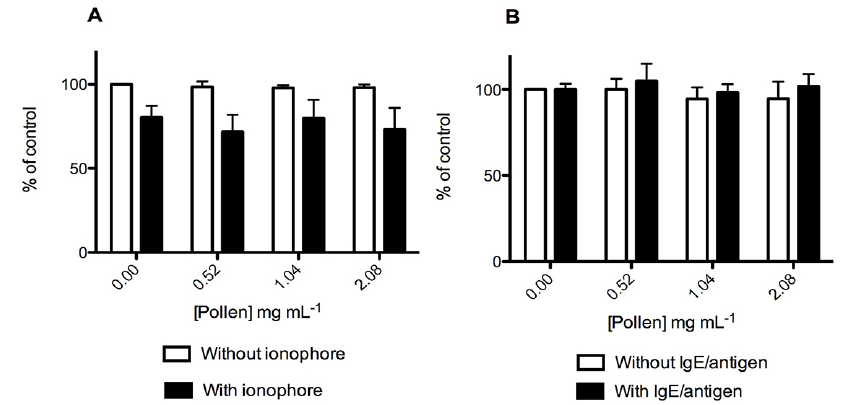
Figure 3. Effect of E. plantagineum bee pollen extract in RBL-2H3 basophils viability, assessed by MTT reduction assay. Values show mean ± SEM of three independent assays performed in duplicate with calcium ionophore (or extract only) and six independent assays performed in duplicate with IgE-DNP – DNP-BSA (or extract only). ( A ) Cells were pre-exposed to the extract for 15 min, followed by 30 min co-exposure to 500 ng/mL calcium ionophore A23187; ( B ) Cells were pre-exposed to 100 ng/mL anti-DNP IgE for 16 h, followed by 1 h extract co-exposure to 100 ng/mL